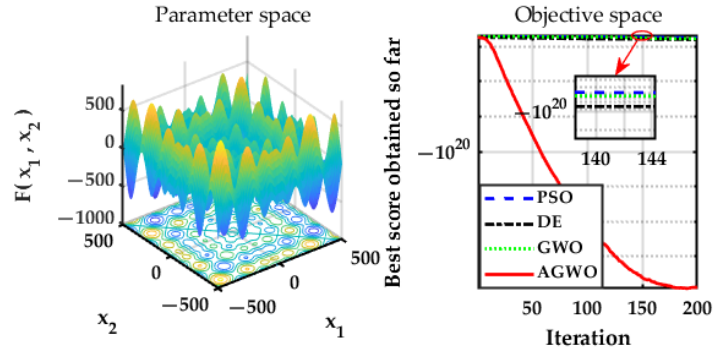
Figure 8. Convergence effect of nonconvex function.